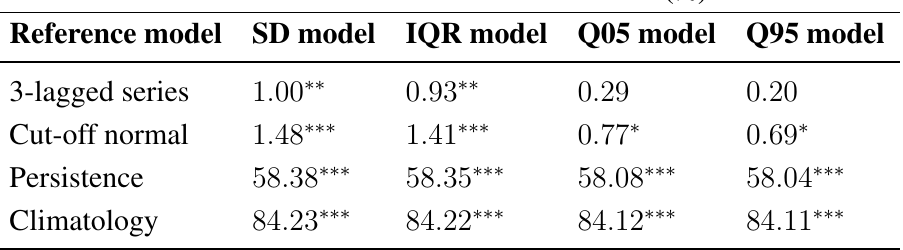
Table 9. Out-of-sample Skill CRPS ( % ) (averaged over all wind farms) for the 1-step ahead CFS optimized models. The scores are just for the first lead time. The asterisks indicate the statistical significance of the gain/loss according to the Amisano and Giacomini test with the following significance codes for the p -value of the test: ***: p ≤ 0 . 01 , **: 0 . 01 < p ≤ 0 . 05 , *: 0 . 05 < p ≤ 0 . 1 .